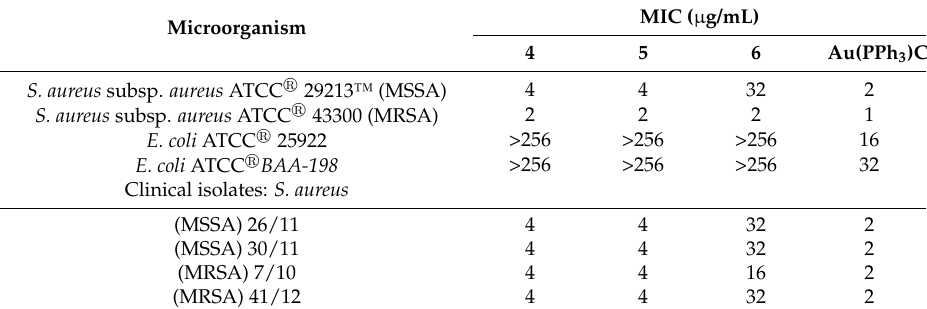
Table 4. In vitro antibacterial activity of complexes 4 – 6 and the Au(PPh 3 )Cl reference compound (MIC µ g/mL). MIC ( µ g/mL) Microorganism 4 5 6 Au(PPh 3 )Cl S. aureus subsp. aureus ATCC (cid:114) 29213™ (MSSA) 4 4 32